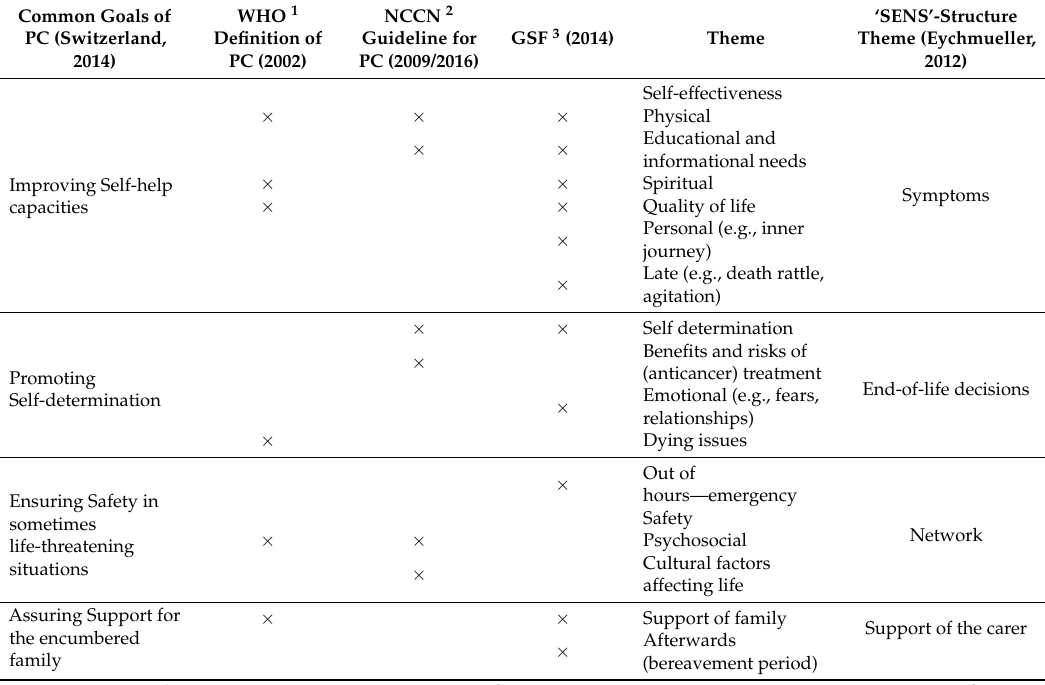
Table 1. Overview of themes discussed in Palliative Care (PC)